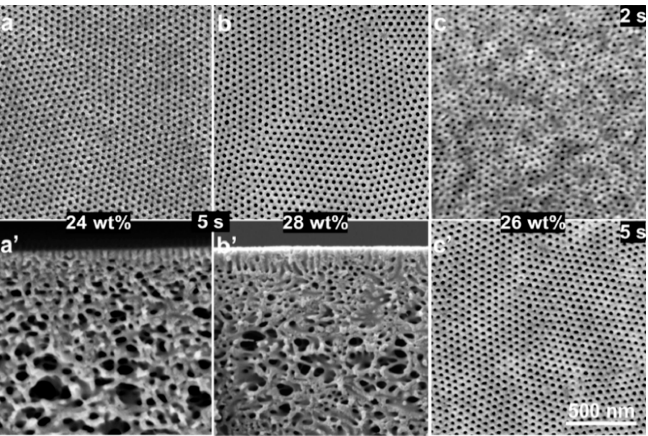
Figure 2. Scanning electron microscopy (SEM) micrographs of the top surfaces ( a , b , c , c’ ) and of cross-sections ( a’ , b’ ) of the flat sheets cast using block copolymer solution with 24 (a,a’), 28 (b,b’) and 26 (c,c’) wt% PS- b -P4VP 18150 in DMF/THF 1/1 (wt/wt) under normal evaporation conditions. Table 1. Influence of evaporation conditions and solution compositions on the average pore diameter in isoporous flat sheets. The pixel size of the SEM micrographs is 2.23 nm. Polymer